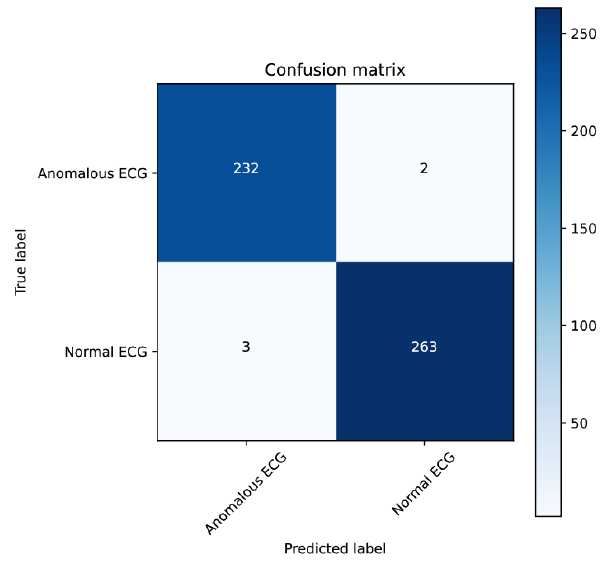
Figure 6. Confusion matrix of the LSTM-predicted result on the test set. Table 2. Comparison of results performance on the ECG5000 validation